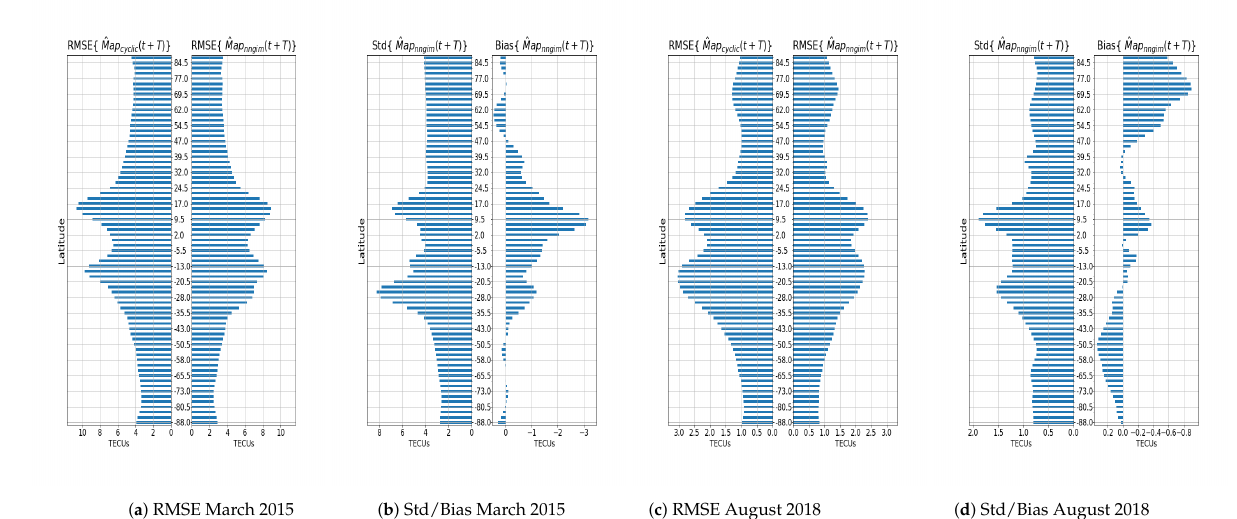
Figure 10. Performance for a horizon T = 6 h. RMSE, bias and standard deviation by latitude. ( a ) Comparison of the RMSE between the NNGIM and the frozen cyclic March 2015, ( b ) standard deviation and bias for the NNGIM March 2015, ( a ) Comparison of the RMSE between the NNGIM and the frozen cyclic August 2018, ( b ) standard deviation and bias for the NNGIM August 2018. Note that the bias and standard deviation are not the same